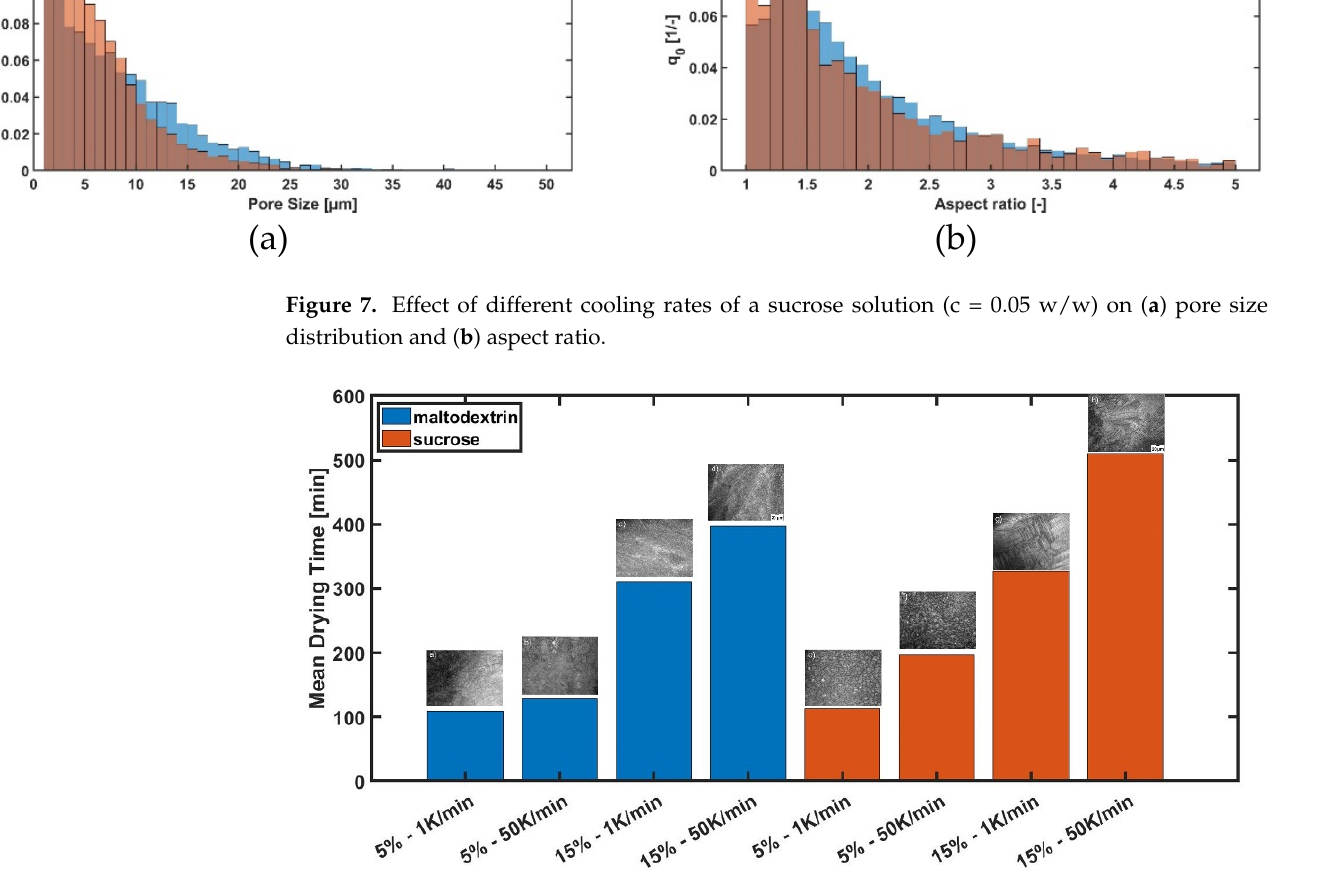
Figure 8. Mean primary drying times.